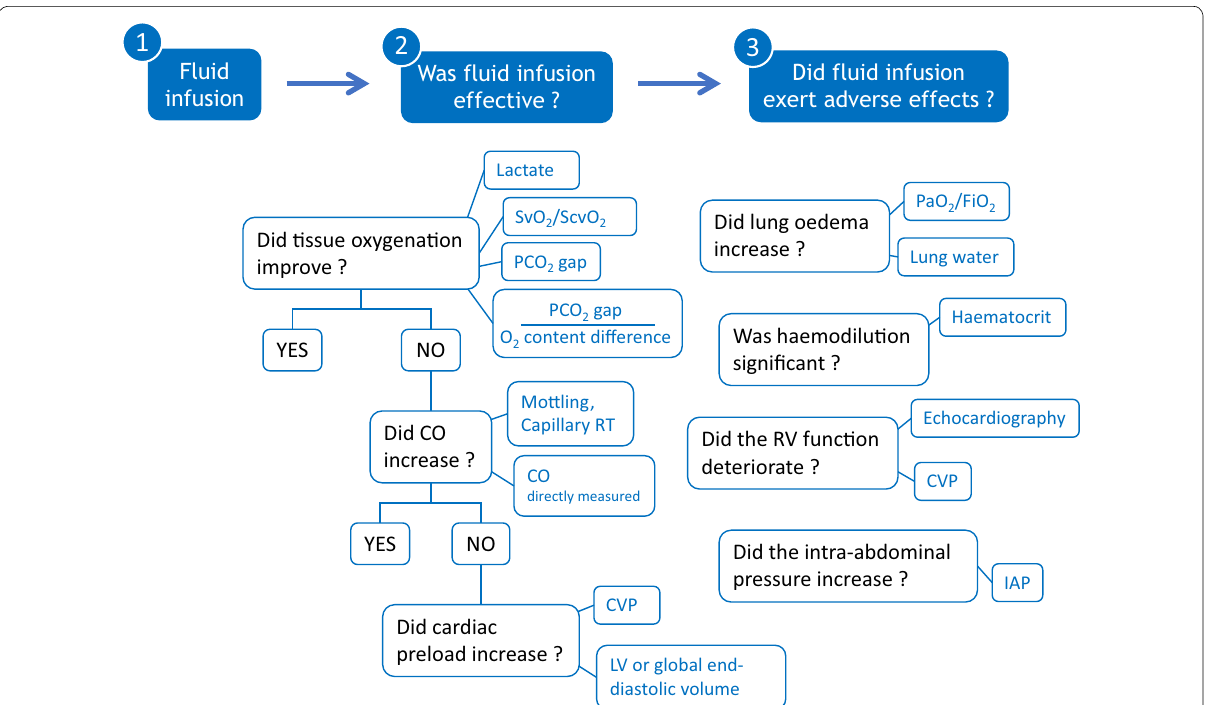
Fig. 2 Summary of the criteria on which the benefits and risks of volume expansion might be assessed. CO cardiac output, CVP central venous pres‑ sure, FiO 2 oxygen inspired fraction, IAP intra‑abdominal pressure, LV left ventricular, PCO 2 carbon dioxide partial pressure, PaO 2 arterial oxygen partial pressure, RT refill time, SvO 2 /ScvO 2 mixed/central venous oxygen